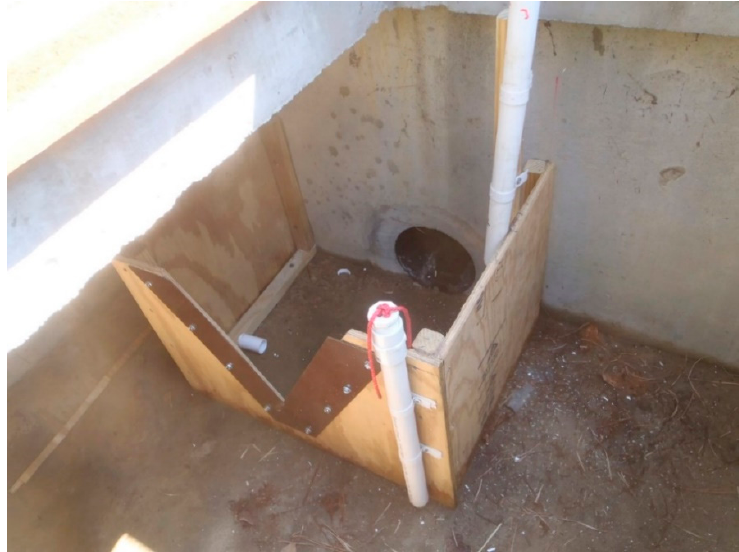
Figure 5. Underdrain outlet weir and associated HOBO logger [47].